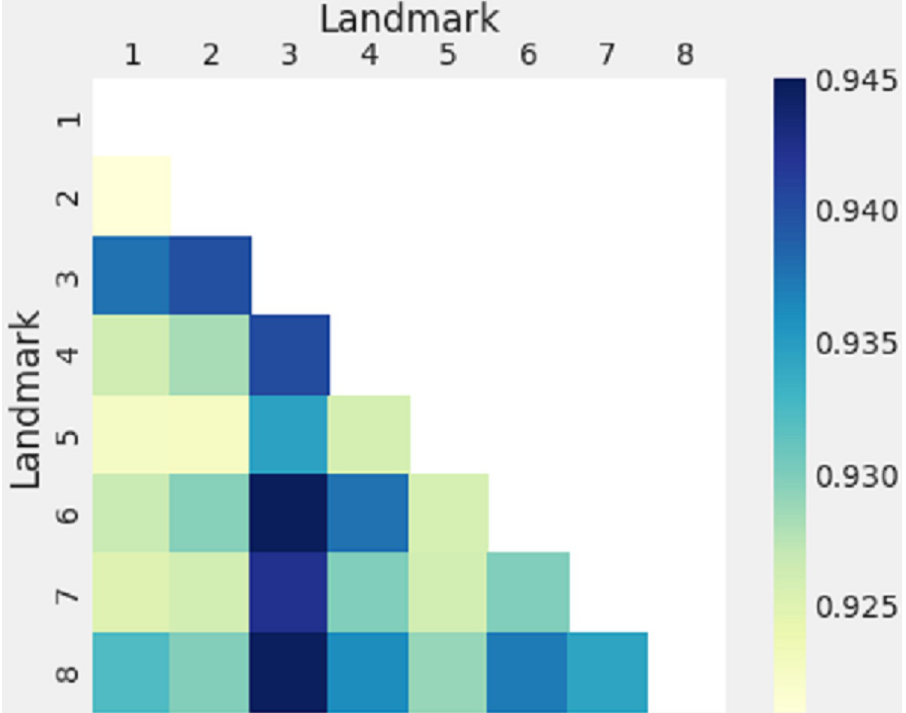
Fig 6. Landmark pair heatmap. Heatmap displaying the average predictive powers of combinations including each landmark pair; note that landmarks three and six make consistently more powerful combinations than other